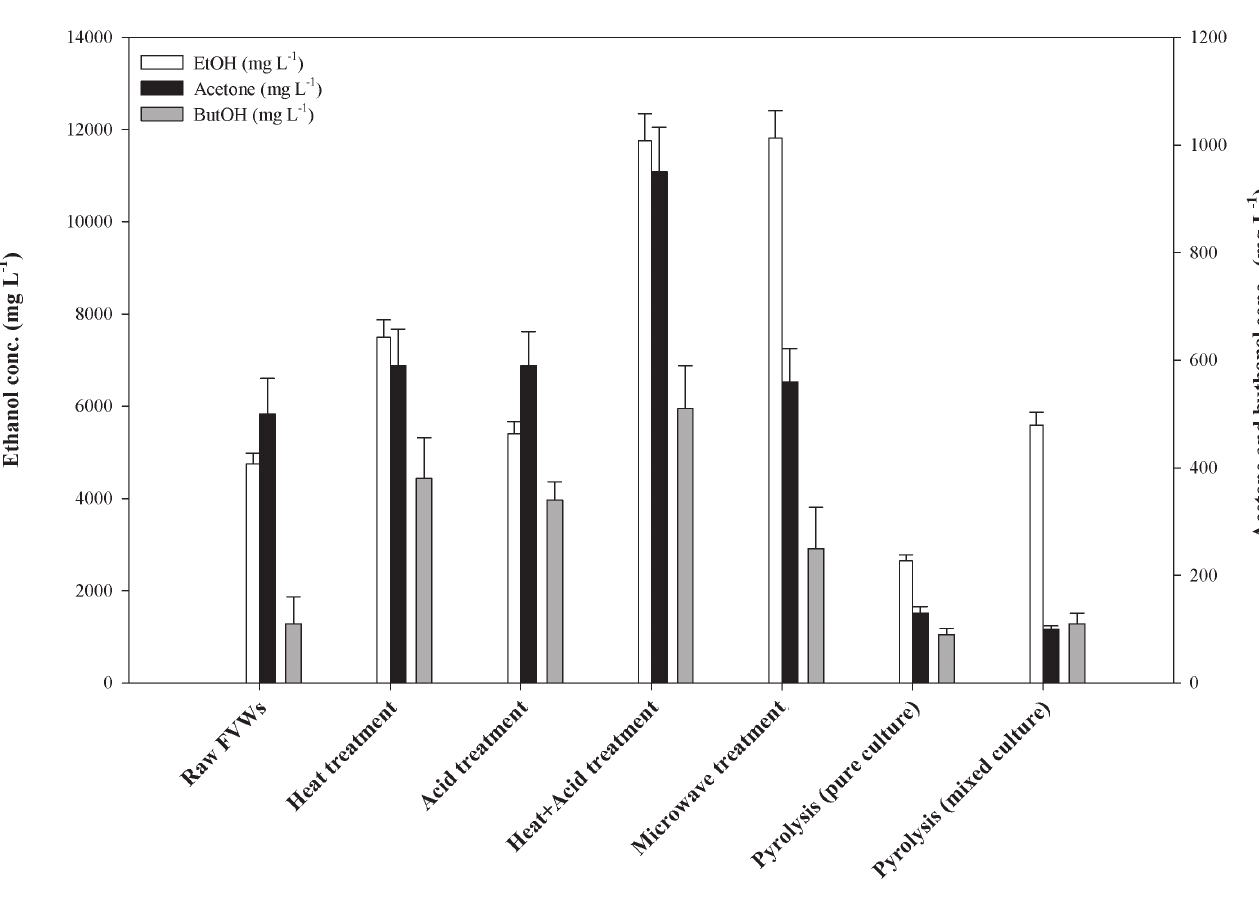
Fig. 7 – Acetone-buthanol-ethanol values of all